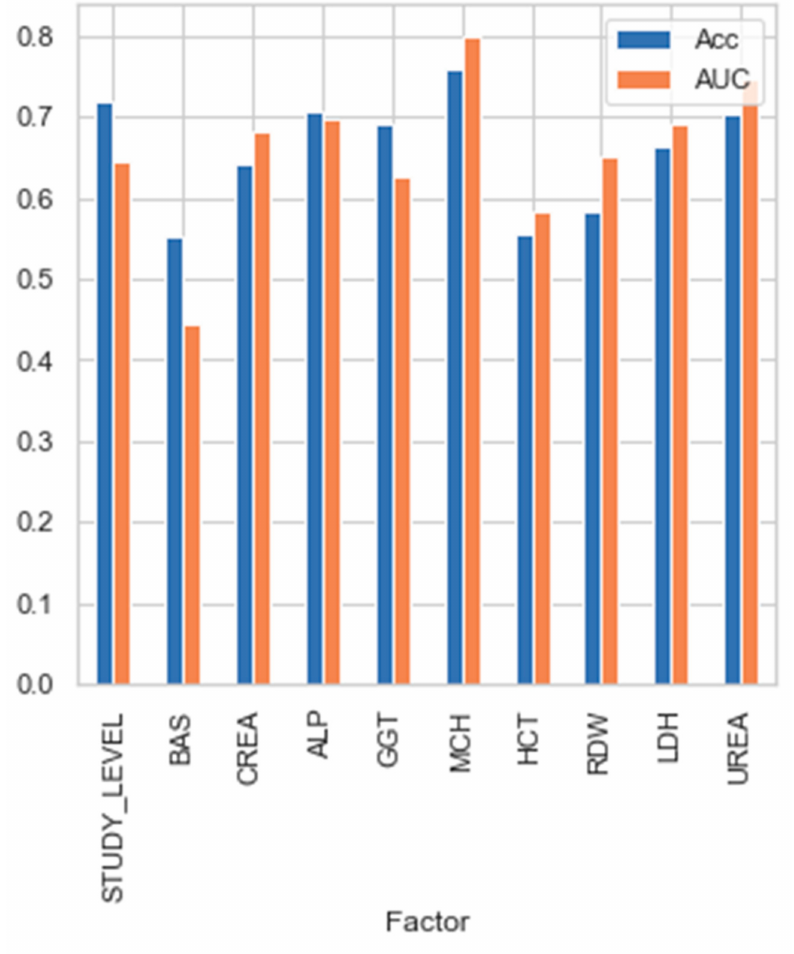
Figure 6. Predictive strength of each parameter selected in the Bayesian